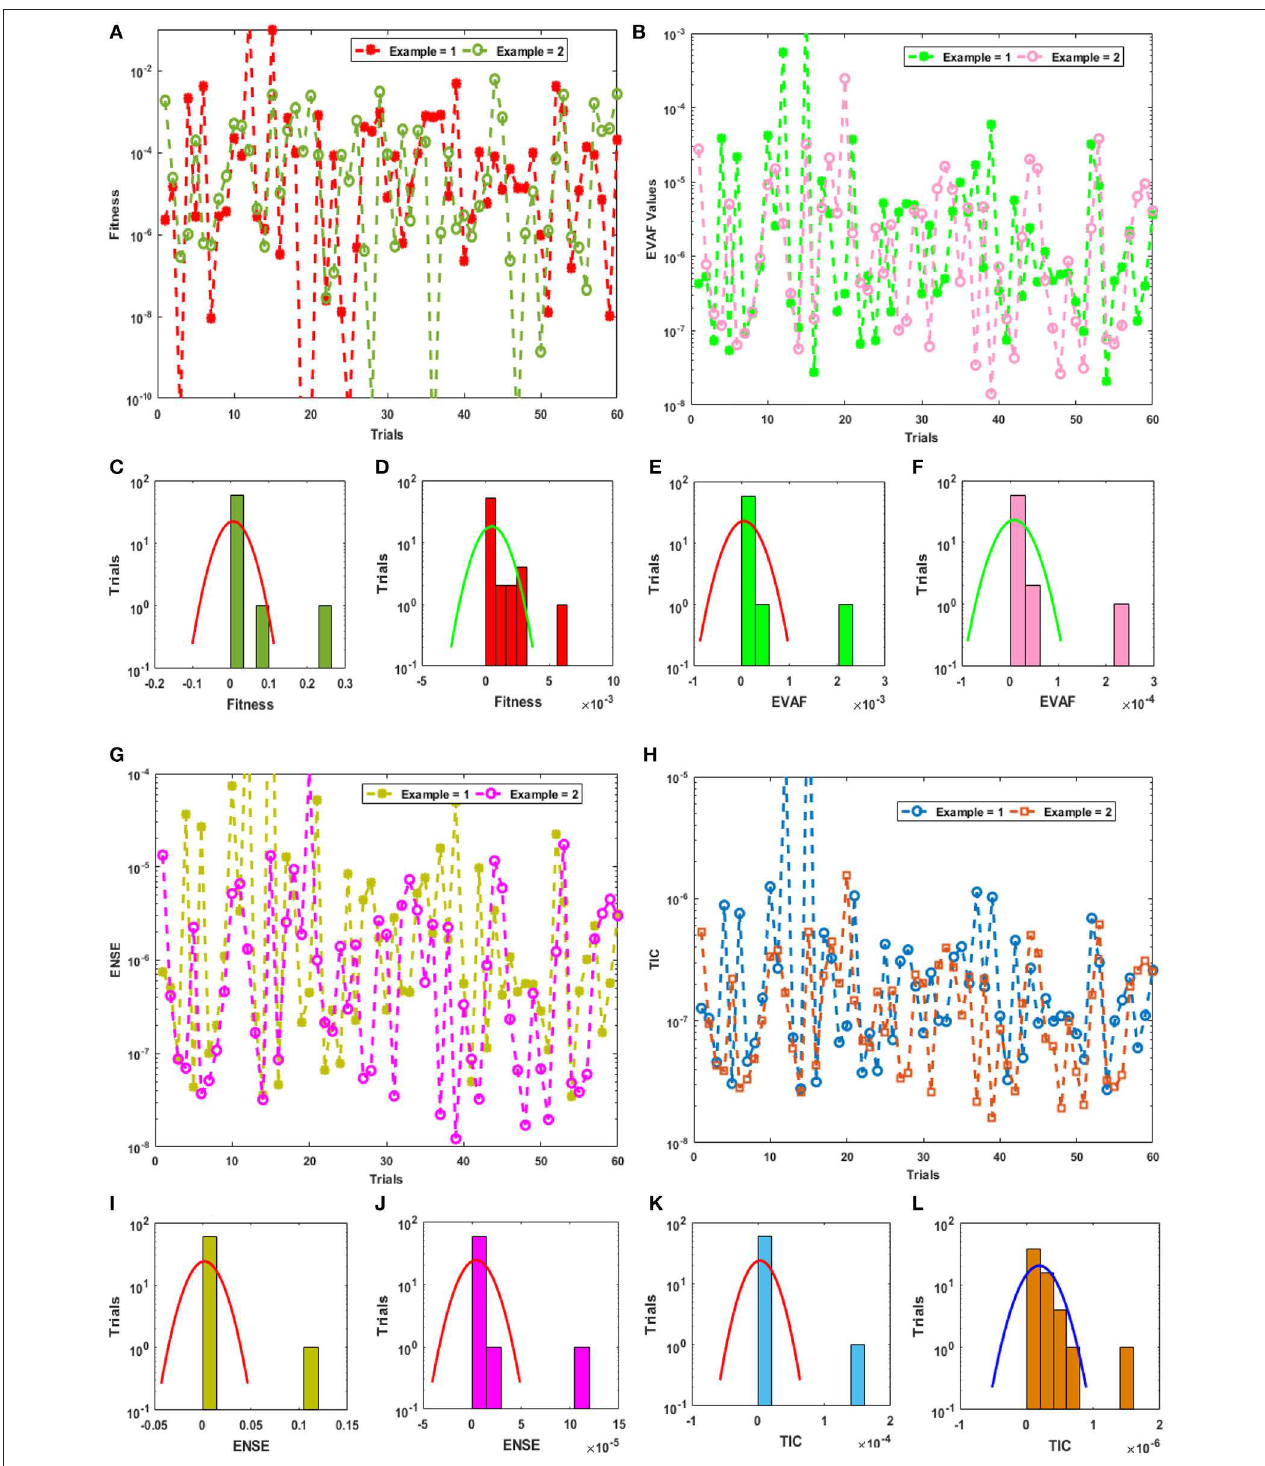
FIGURE 3 | Statistical analysis for Fitness, EVAF, ENSE, and TIC values along with the histograms for 5 numbers of neurons. (A) Analysis through Fitness values. (B) Analysis through EVAF values. (C) Fitness histogram for Example 1. (D) Fitness histogram for Example 2. (E) EVAF histogram for Example 1. (F) EVAF histogram for Example 2. (G) Analysis through ENSE values. (H) Analysis through TIC values. (I) ENSE histogram for Example 1. (J) ENSE histogram for Example 2. (K) TIC histogram for Example 1. (L) TIC histogram for Example 2.